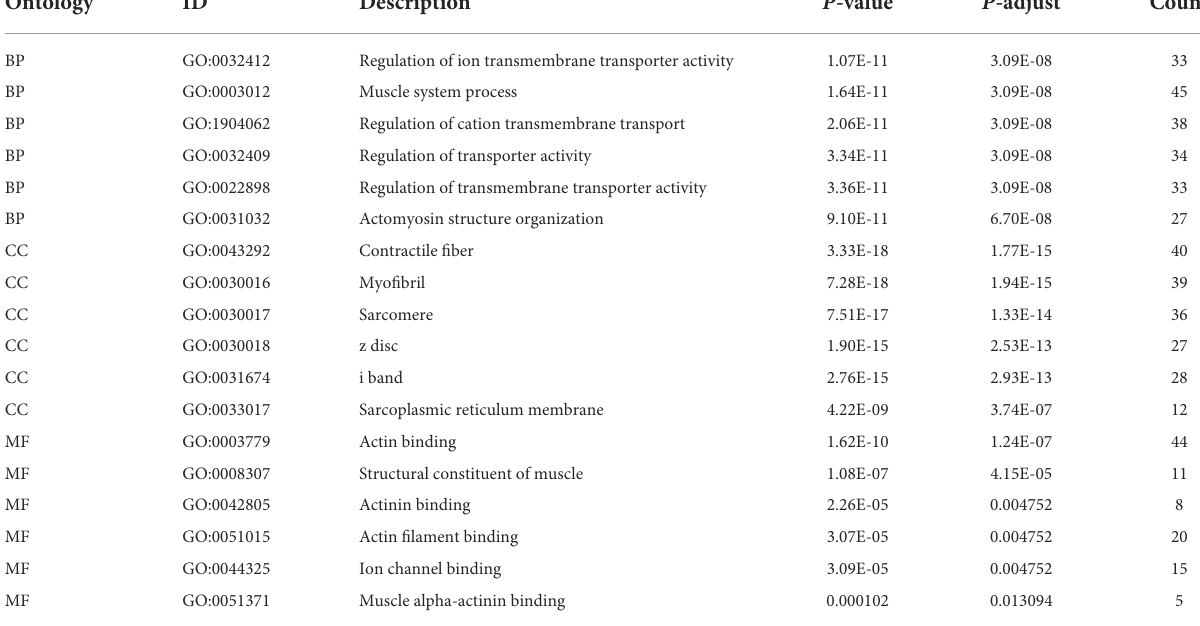
TABLE 1 Gene ontology (GO) pathway enrichment